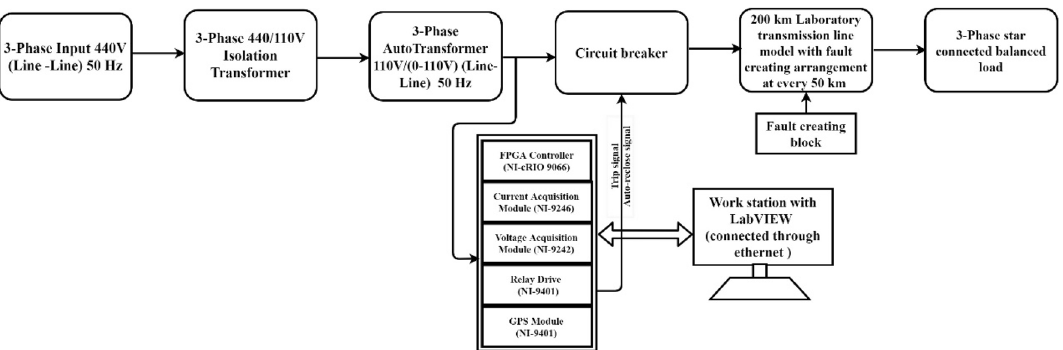
Fig. 9 Laboratory set-up for fault analysis on transmission